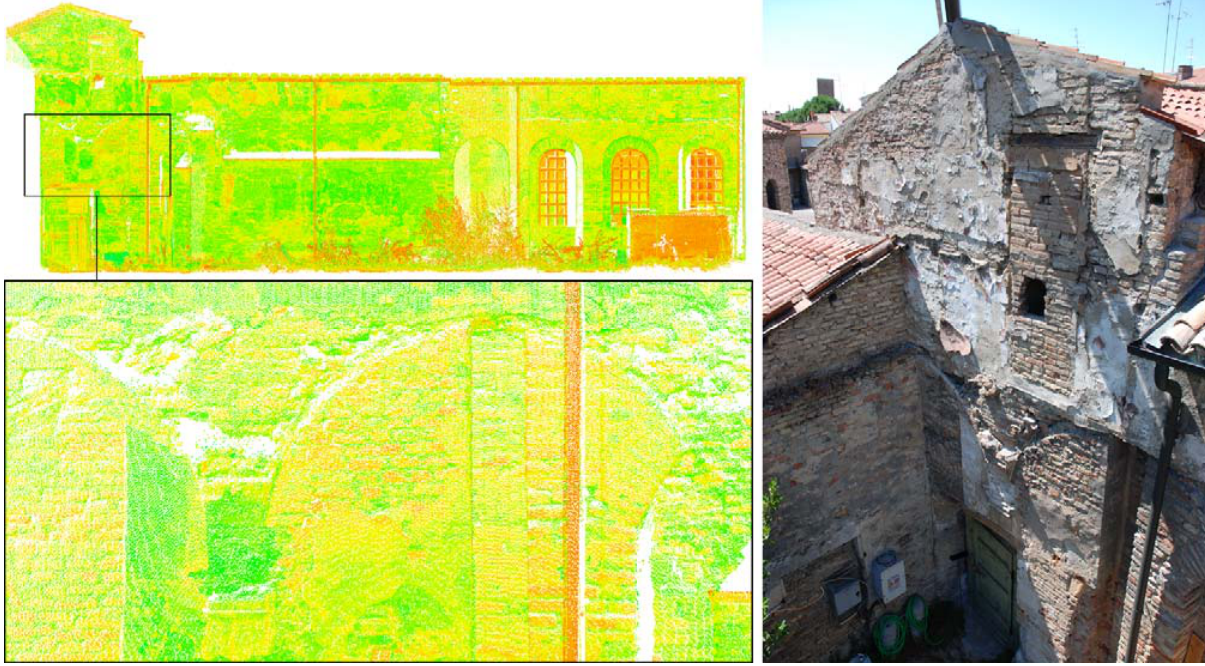
Figure 5. Complex wall of the Chiesa dello Spirito Santo facing a courtyard. In this case, laser scanner survey can ease its accurate and detailed documentation, as the acquired information is much more